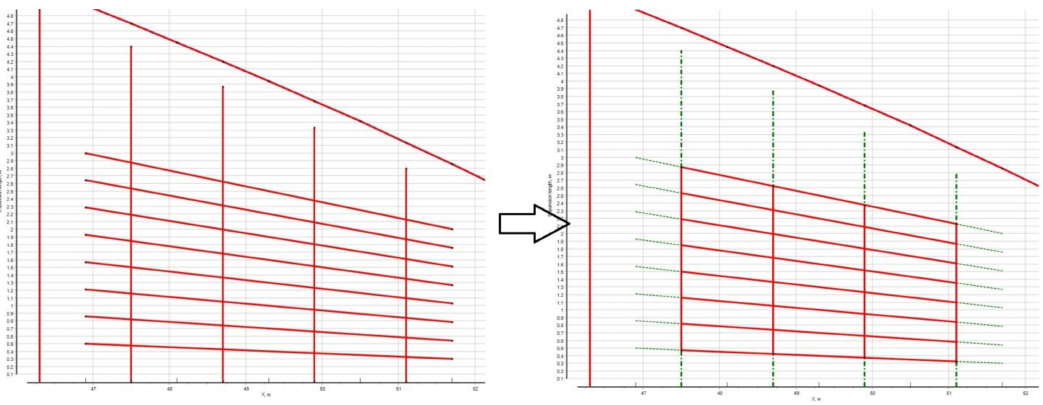
Figure 9. Result of deleting borders for EPPs that are not anchored at both